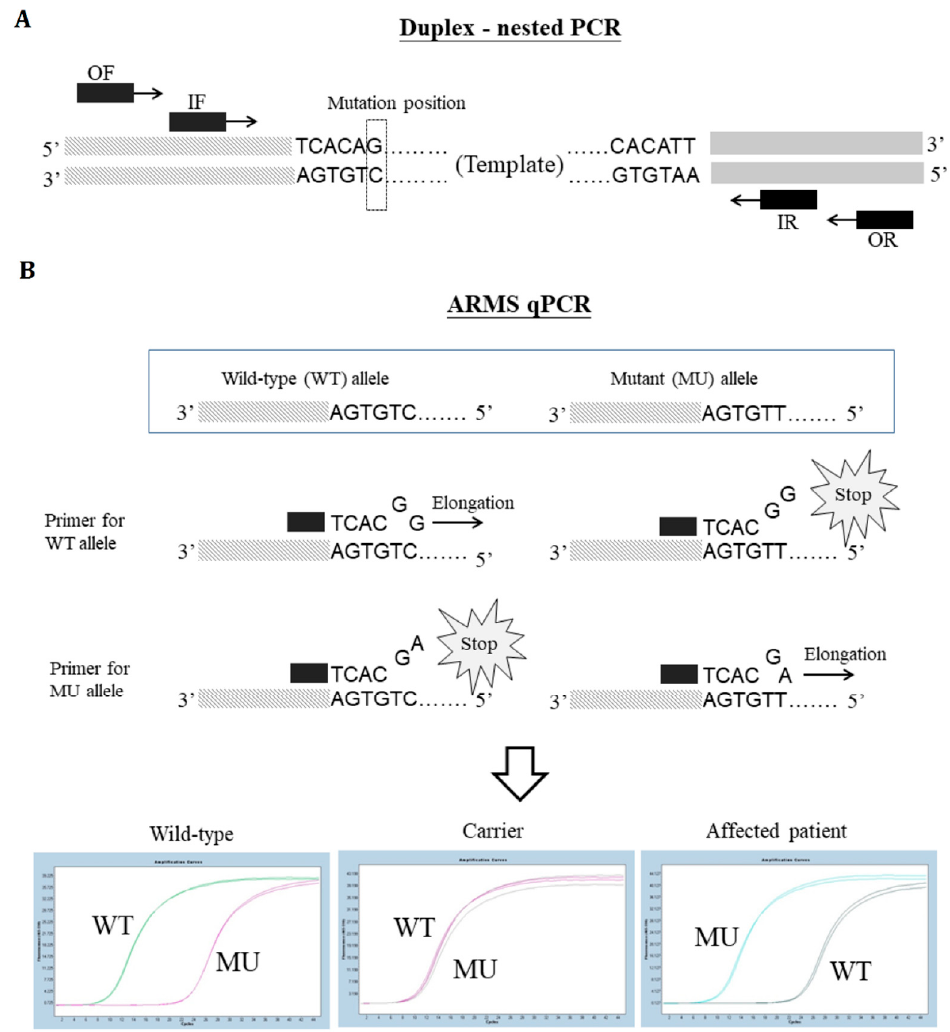
Figure 1. Schematic diagram of a duplex-nested amplification refractory mutation system quantitative polymerase chain reaction (ARMS-qPCR) for the preimplantation genetic diagnosis (PGD) of a point mutation. ( A ) Duplex-nested PCR was used to amplify a region including the mutation position. OF and OR, outer primer set; IF and IR, inner primer set. ( B ) ARMS-qPCR using di ff erent primers to separate the wild-type (WT) and mutant (MU) alleles. A representative ARMS-qPCR experiment for the following genotypes in duplication: wild-type (homozygous WT), carrier (heterozygous WT / MU), and a ff ected patient (homozygous MU). Black and grey dotted histograms indicate the primers and template deoxyribonucleic acid (DNA). Di ff erent color curves in Figure 1B indicate di ff erent runs of ARMS-qPCR testing.